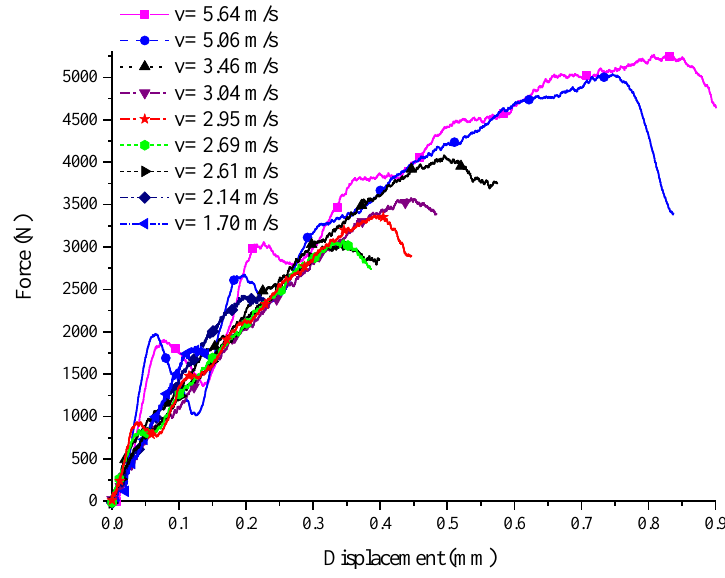
Figure 12. Load–displacement curves of 45 ◦ SCS at different impact speeds. To further expound the development of the SCS from yield to failure, two experiments with different impact velocities for the 45 ◦ SCS were analyzed. Figure 13 presents the load–time curve of 45 ◦ SCS failure (v = 5.64 m/s) and yield without failure (v = 3.46 m/s) are given, respectively. By comparison, it can be seen that the curve at v = 5.64 m/s had the maximum signal oscillation amplitude at approximately 25 us during the rising process. This is probably attributed to the local failure and damage the specimen had undergone during the deformation process, which caused the reduced carrying load. When the specimen began to yield, the load dropped rapidly at an amplitude dF2 = 1390 N, much larger than dF1 = 325 N, the drop amplitude when v = 3.46 m/s. Meanwhile, the retrieved specimen in the v = 5.64 m/s experiment was found to have completely